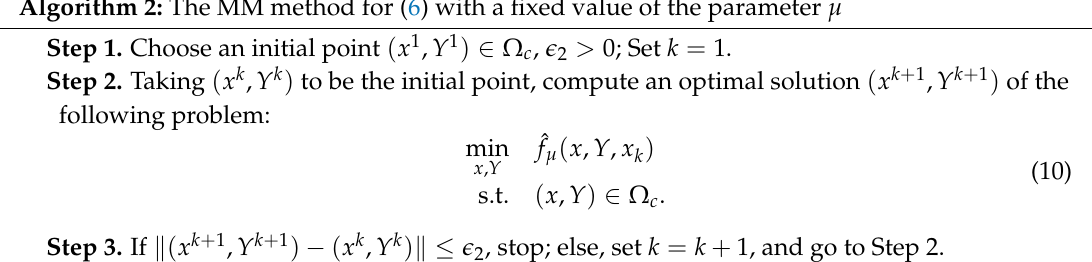
Algorithm 2: The MM method for (6) with a fixed value of the parameter